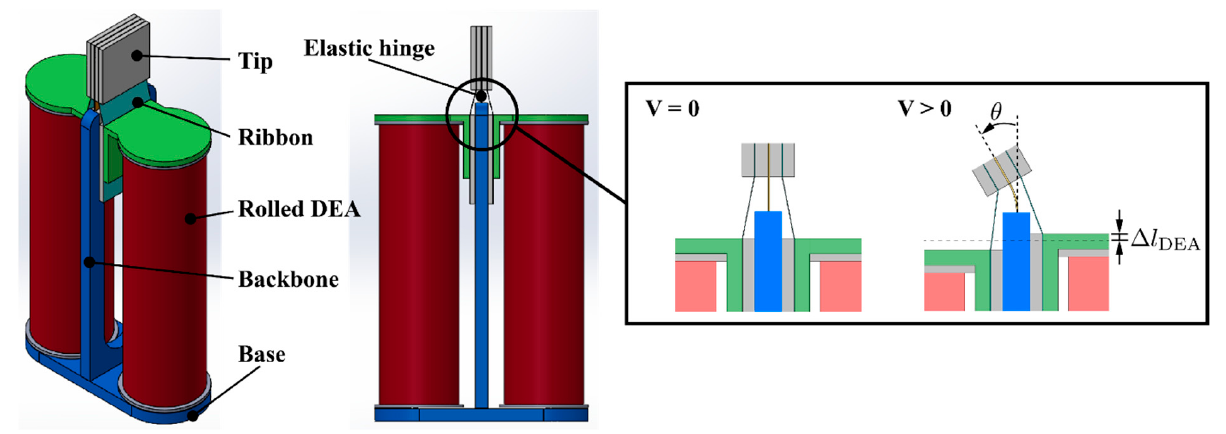
Figure 1. Structure and working principle of the antagonistic actuator proposed in this study.